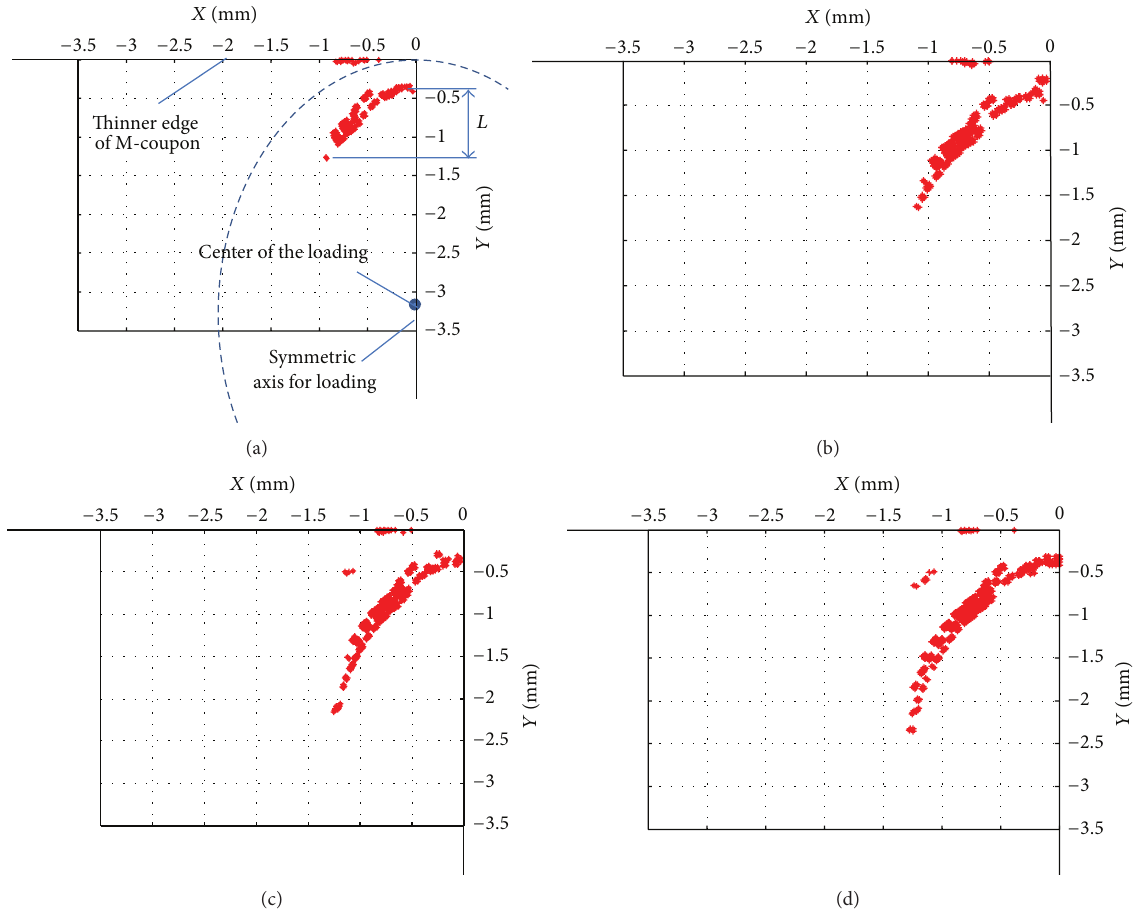
Figure 9: Simulated crack locations close to the middle plane by using different values of the effective plastic displacement coefficient to failure (a) 0.8 𝜇 m; (b) 0.6 𝜇 m; (c) 0.4 𝜇 m; and (d) 0.3 𝜇